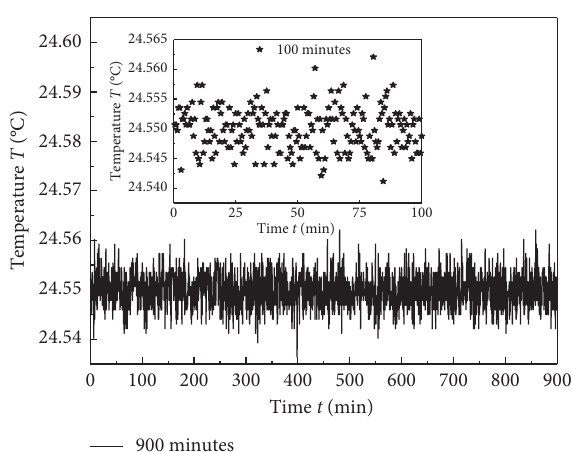
Figure 4: Temperature stability test during 15